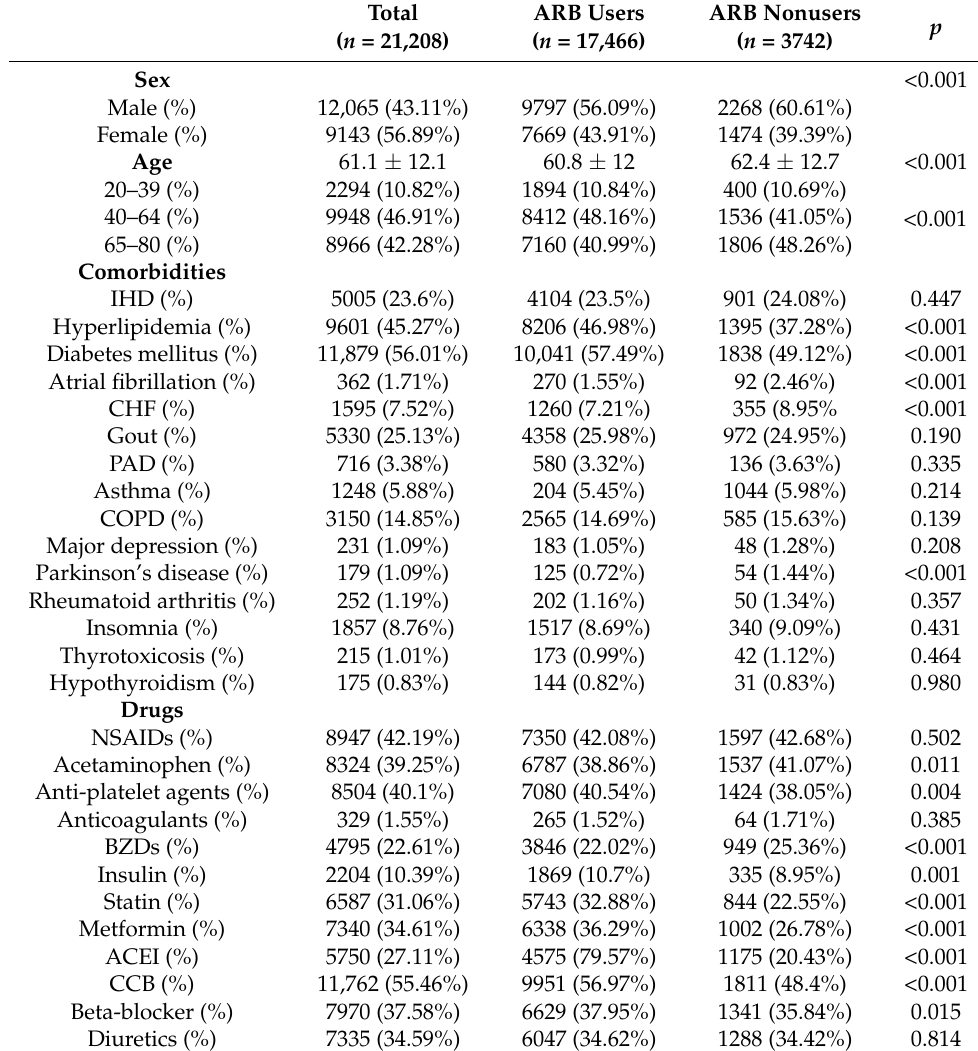
Table 1. Baseline characteristics of chronic kidney disease (CKD) patients with